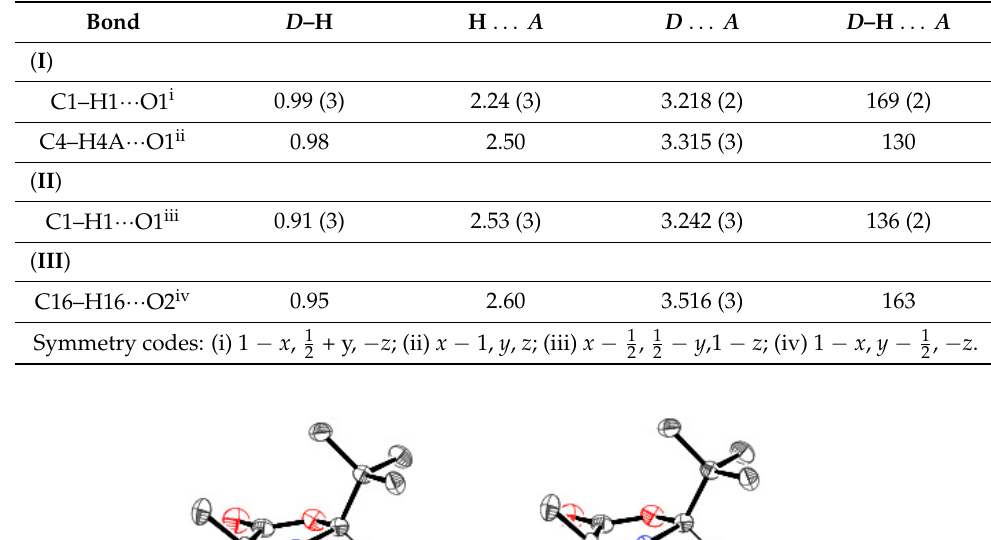
Table 2. Hydrogen bond data (Å, ◦ ) for ( I )–( III ).